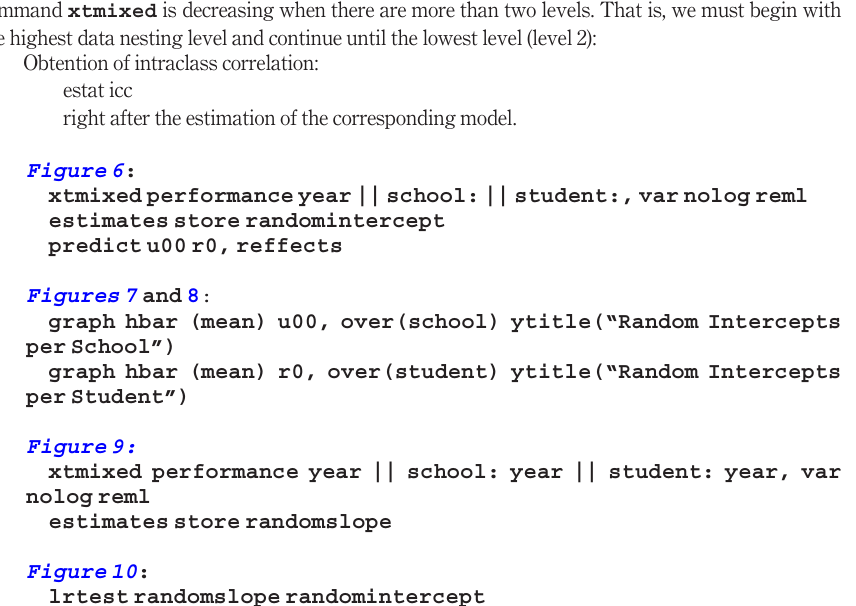
Figure 9: xtmixed performance year || school: year || student: year,